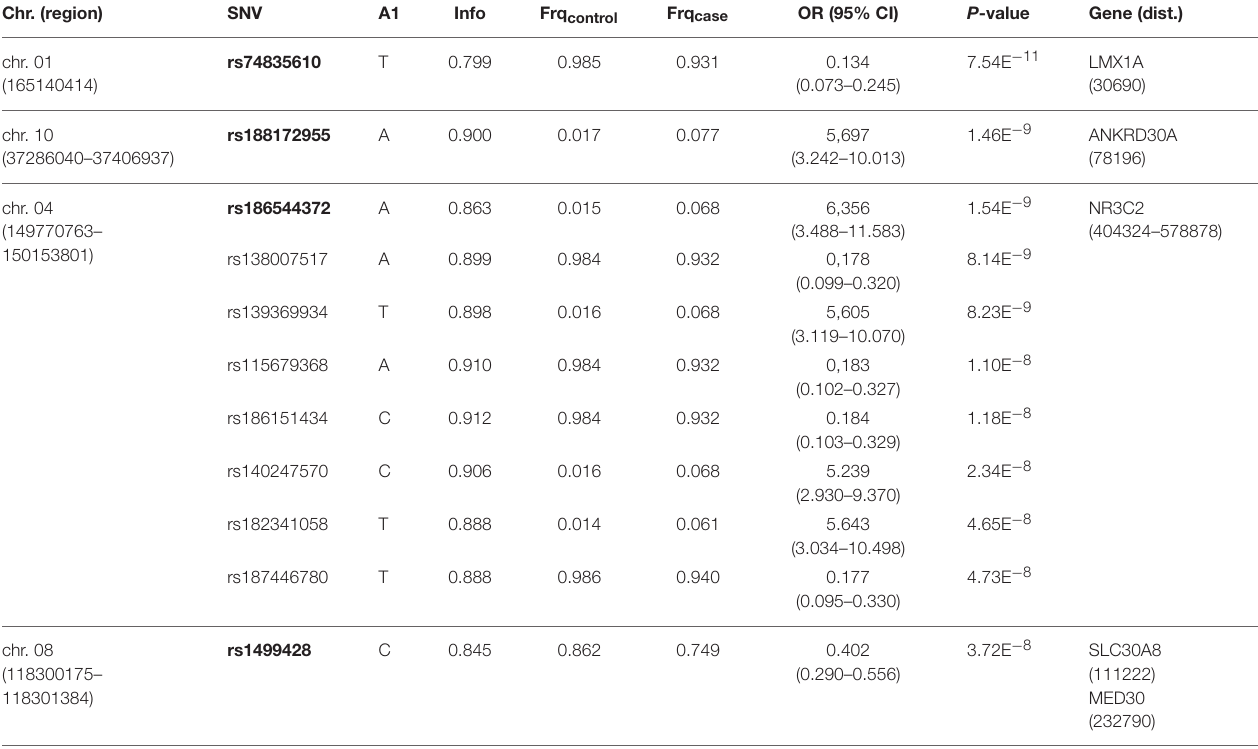
SNV associations are sorted by P-value. Chromosome and position denote the associated region surrounding the index SNV (in bold) containing 1 or more variation in LD (r 2 > 0.6) with the index SNV. A1, reference allele; Frq, allele frequency; OR, odds ratio; CI, confidence interval; gene, next protein coding gene; dist., distance to index SNV in